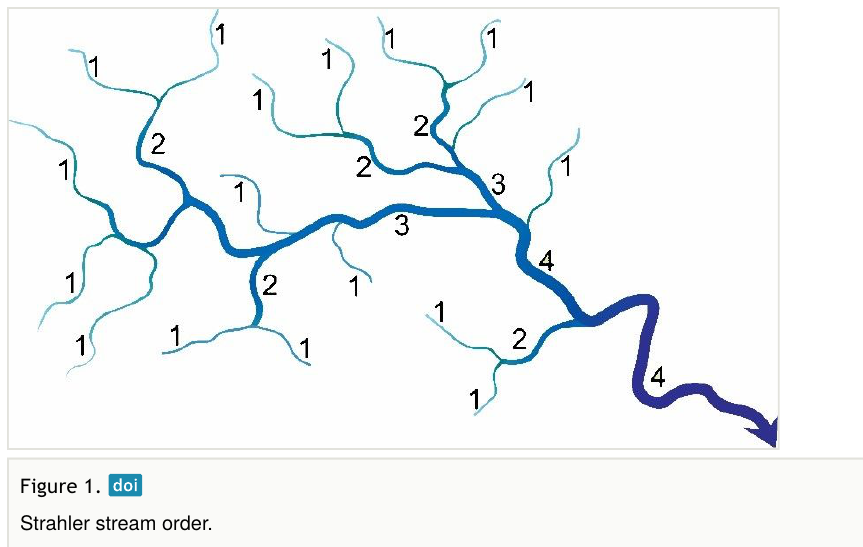
Strahler stream